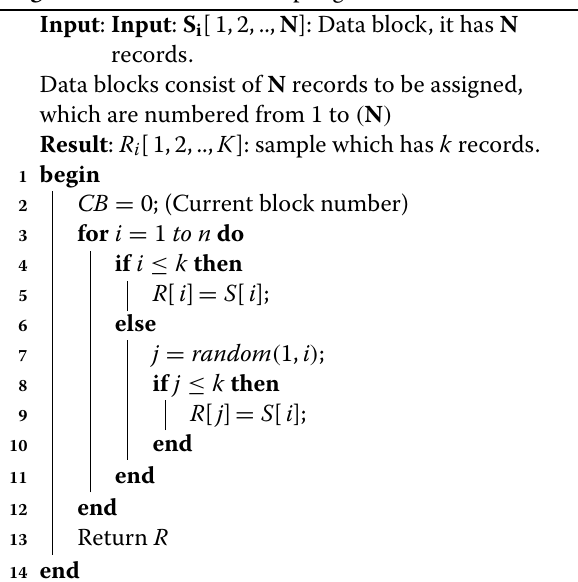
Algorithm 1: Reservoir